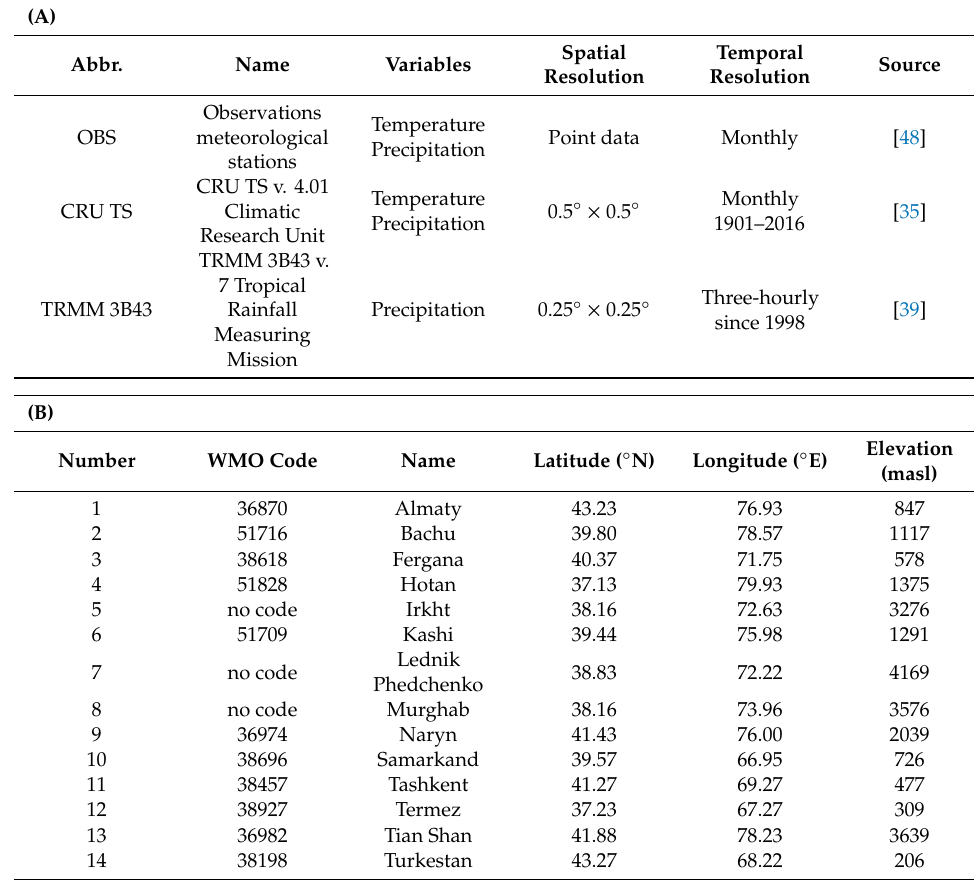
Table 1. Overview of data sources used in this study ( A ). Information of meteorological stations used for validation ( B